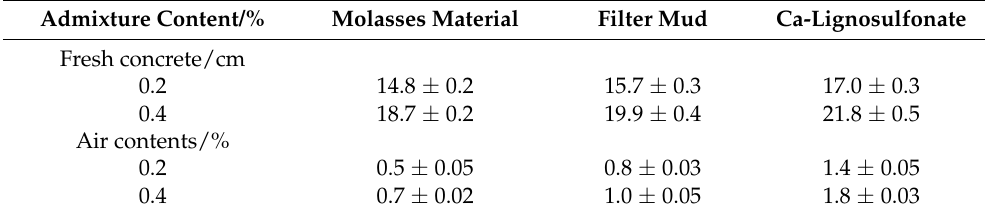
Table 4. Workability properties and air contents of fresh